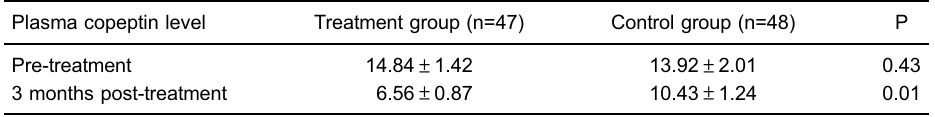
Table 2. Comparison of plasma copeptin level of ischemic stroke patients treated or not with escitalopram at